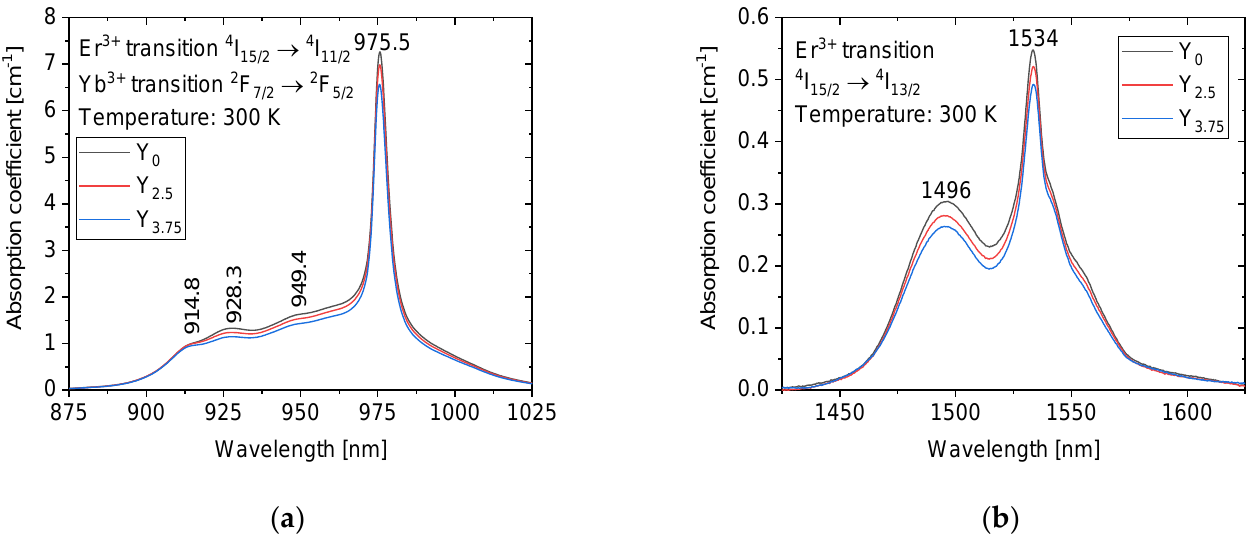
Figure 5. The absorption bands centered at 975 nm ( a ) and at 1534 nm ( b ) of the investigated glasses. The absorption cross-sections at 975 nm and at 1534 nm were calculated using Equation (1) and were found to be (9.33 ± 0.05) × 10 − 20 cm 2 and (0.70 ± 0.05) × 10 − 20 cm 2 , respectively, for the glass Y 0 , and (8.39 ± 0.05) × 10 − 20 cm 2 and (0.63 ± 0.05) × 10 − 20 , re- spectively for the glass Y 3.75 . Within 10%, the absorption cross-section remains unchanged as the Y 2 O 3 content increases, confirming that the sites of the rare-earth ions are not strongly impacted by the changes in the glass